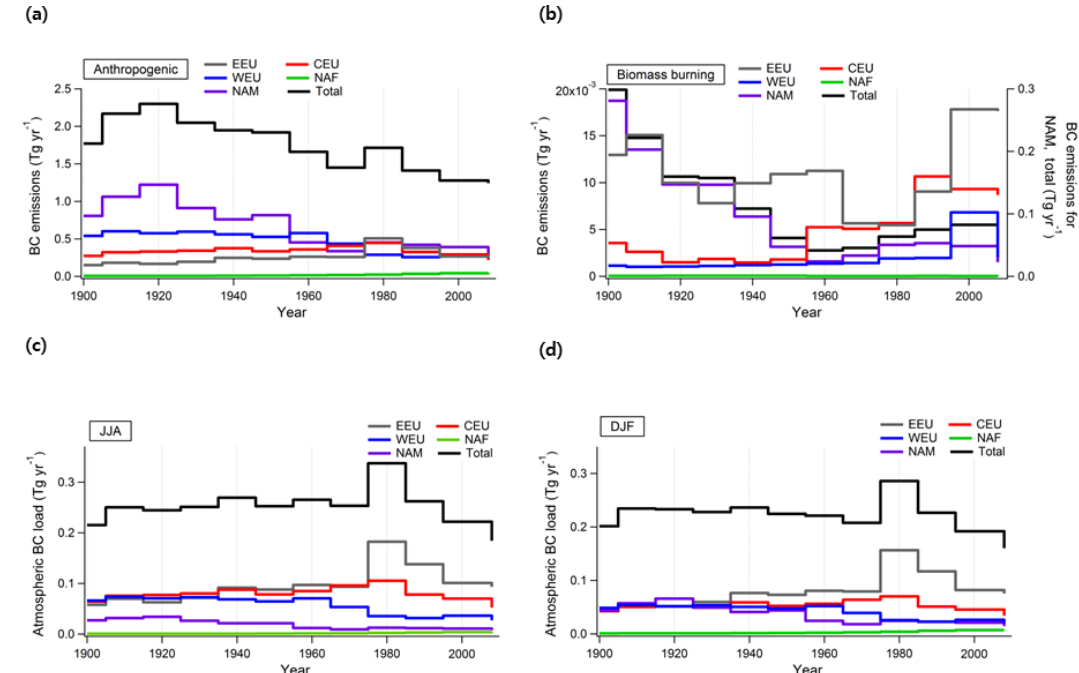
Figure 8. Historic regional BC emissions and atmospheric BC load at ELB for the period 1900–2008. In (a) and (b) , anthropogenic and biomass burning (forest fires and savanna burning) BC emissions estimated by ACCMIP and MACCity (Diehl et al., 2012; Granier et al., 2011; Lamarque et al., 2010; van der Werf et al., 2006). In (c) and (d) , atmospheric BC load (Tgyr − 1 ) is calculated by multiplying decadal-scale BC emissions in each region (a, b) by their relative contribution to the entire footprint area of the ELB site (Fig. 7). In (c) , both anthropogenic and biomass burning emissions are used for the reconstruction for JJA, as this type of biomass burning (forest fires and savanna burning) is the most frequent in summer, and in (d) , only anthropogenic emissions are used for